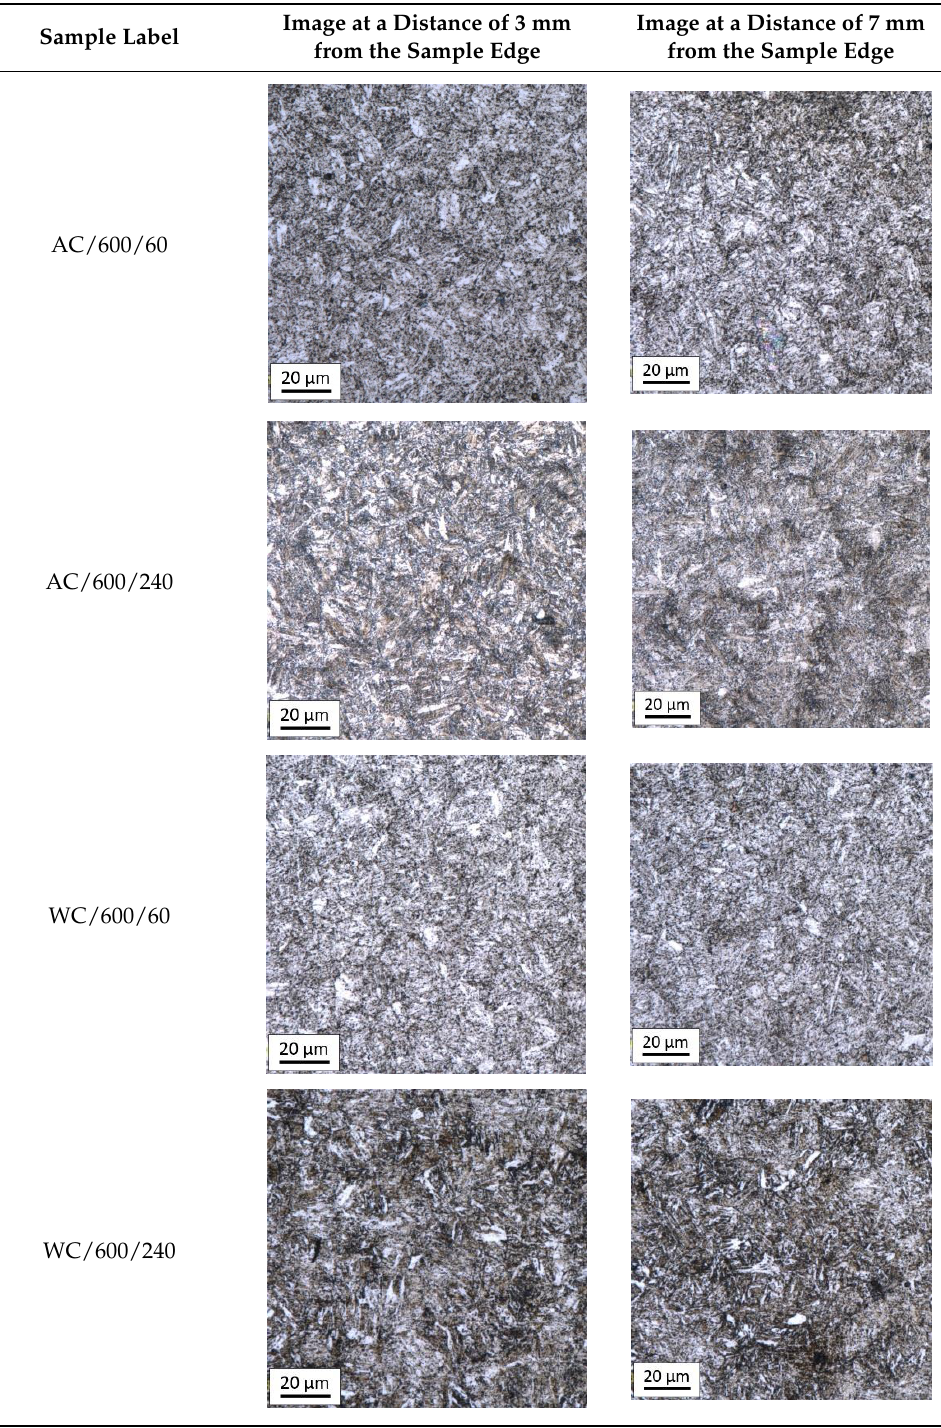
Table 5. Microstructure of steel after heating at 600 °C for 60 min and 240 min with air-cooling and water-cooling.